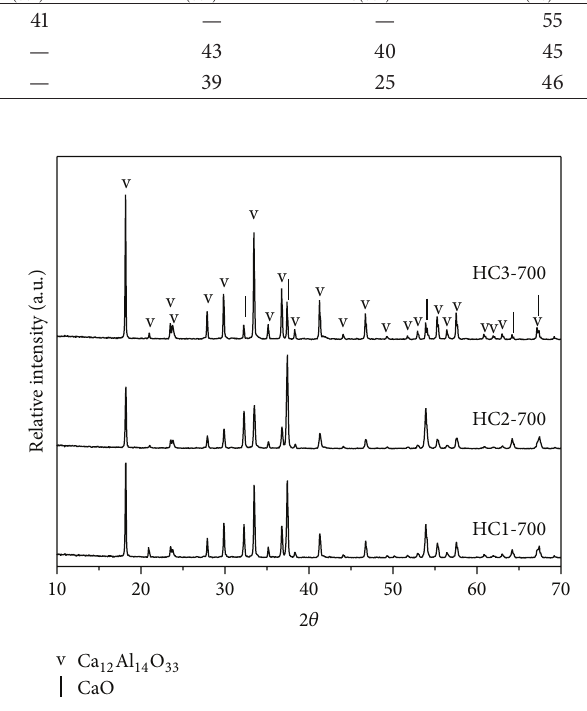
Figure 1: XRD powder patterns of the fresh samples.